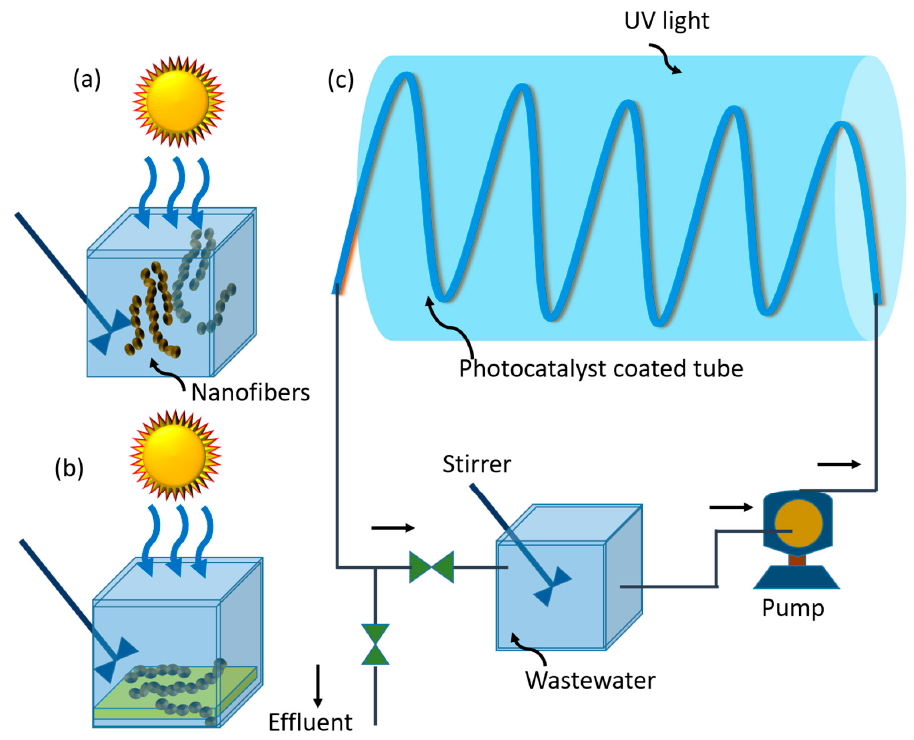
Figure 15. Different types of photocatalytic reactor arrangements: ( a ) slurry reactor; ( b ) immobilized reactor; and ( c ) continuous tubular flow reactor.